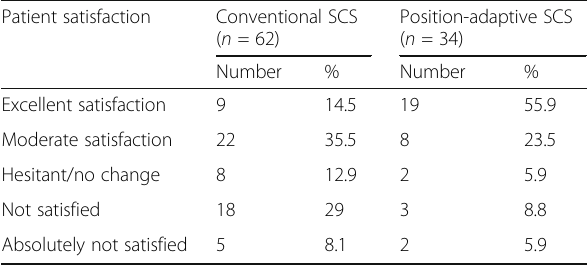
Table 2 The degree of patient satisfaction after the procedure in both treatment groups Patient